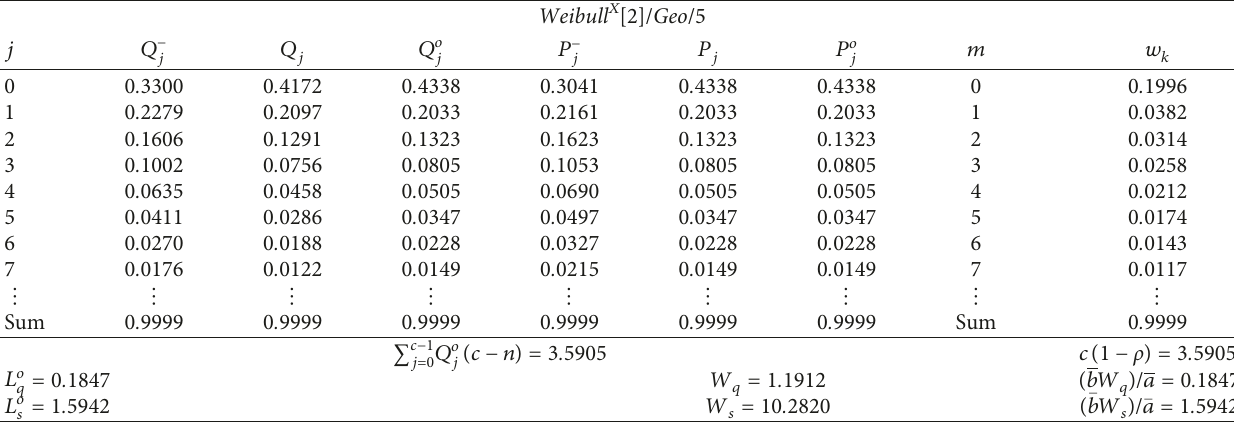
Table 7: Inter-batch-arrival pattern is SLN with a